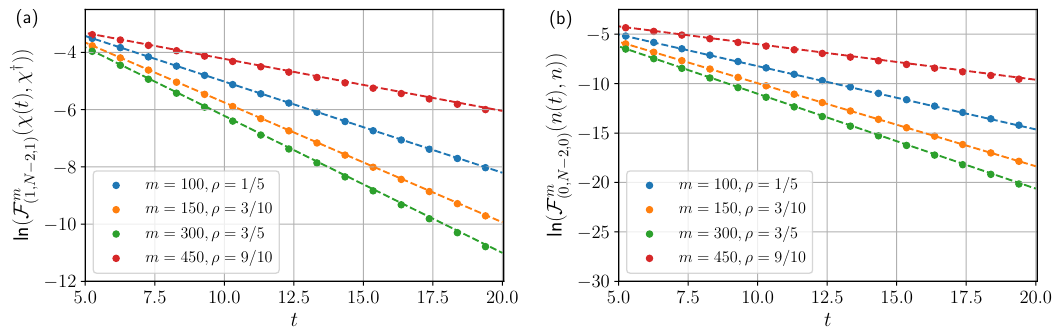
and intercept late